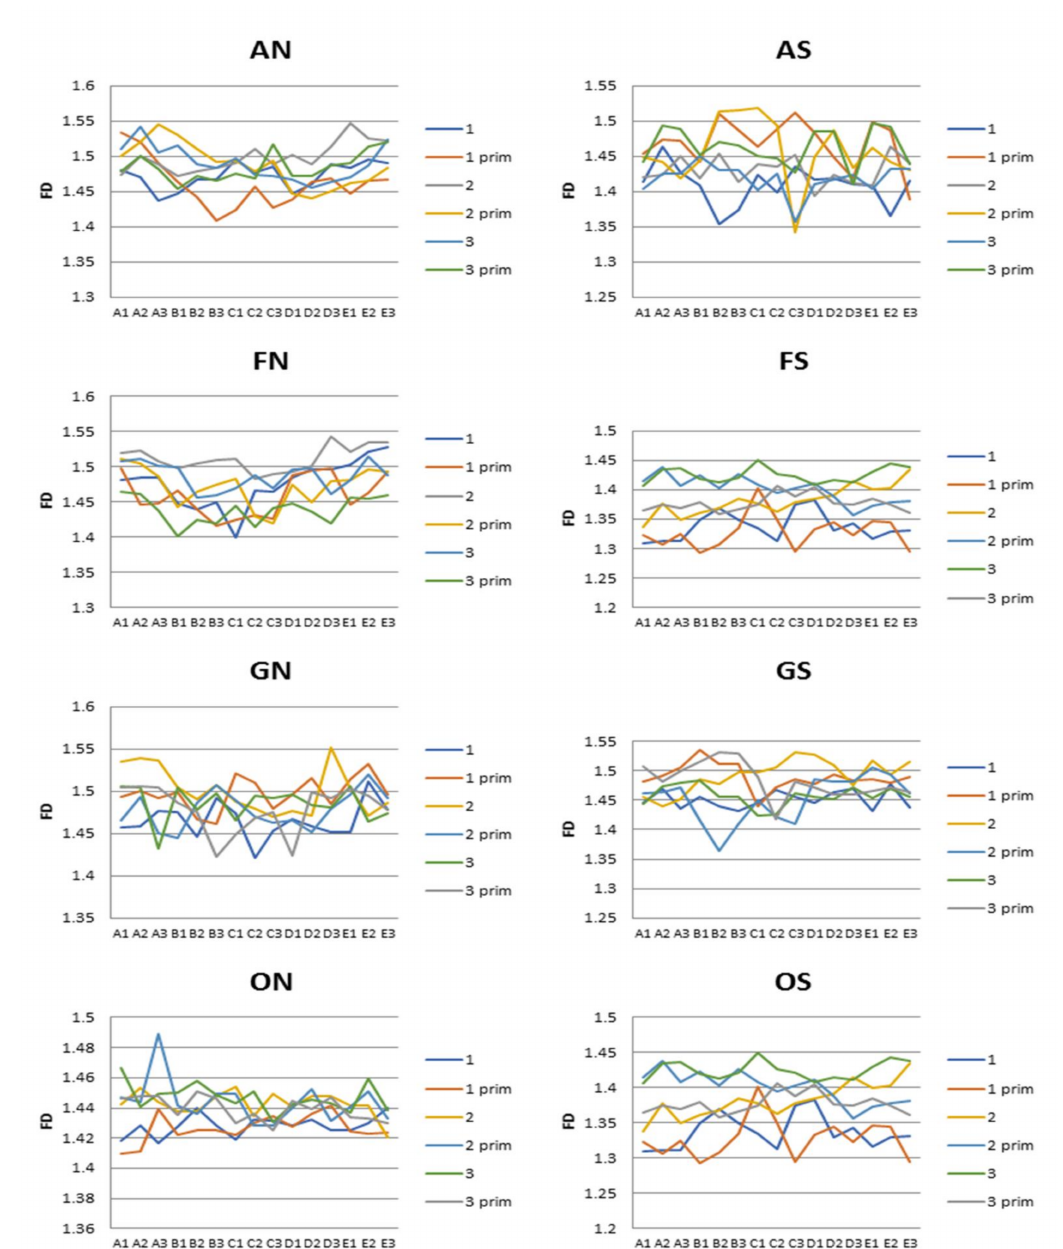
Figure 3. Values of fractal dimension on all measurement points through the length of wires (FD—fractal dimension, A1–E3—measure points, AN—Adenta NiTi, FN—Forestadent NiTi, ON—Ormco NiTi, GN—G&H NiTi, AS—Adenta Steel, FS—Forestadent Steel, OS—Ormco Steel, GS—G&H